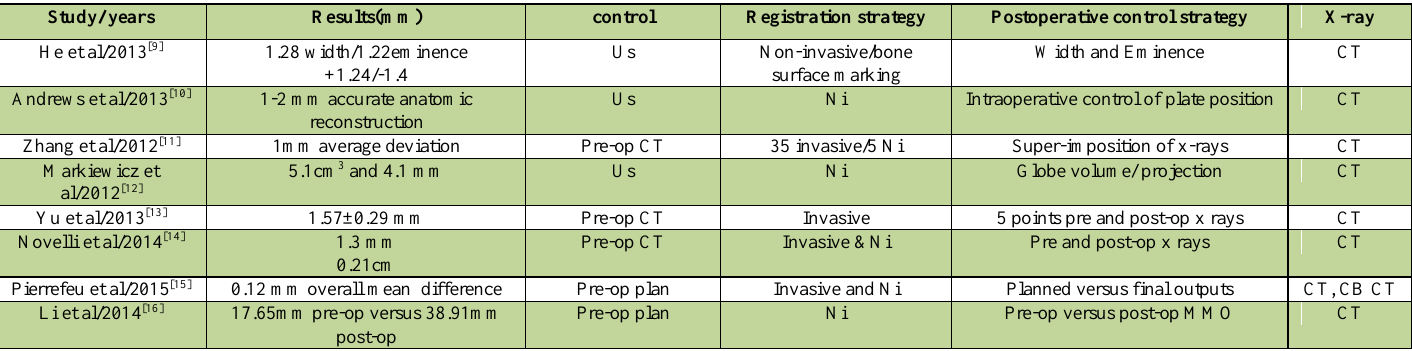
Table 2. Outcome of